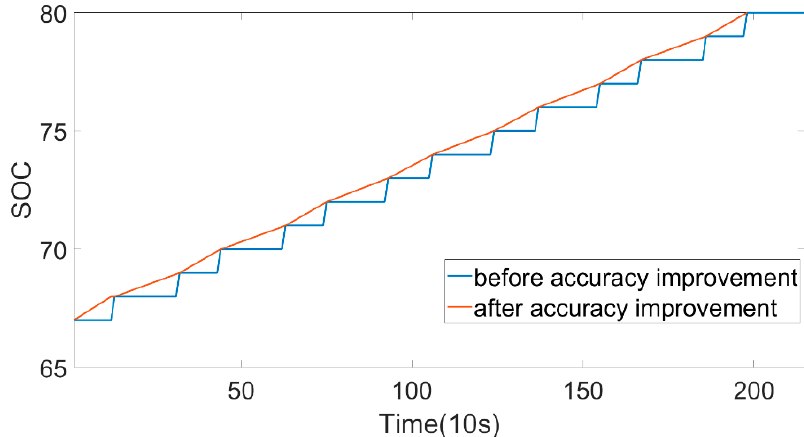
Figure 1. The flow chart of SOH estimation and prediction based on real-world data.